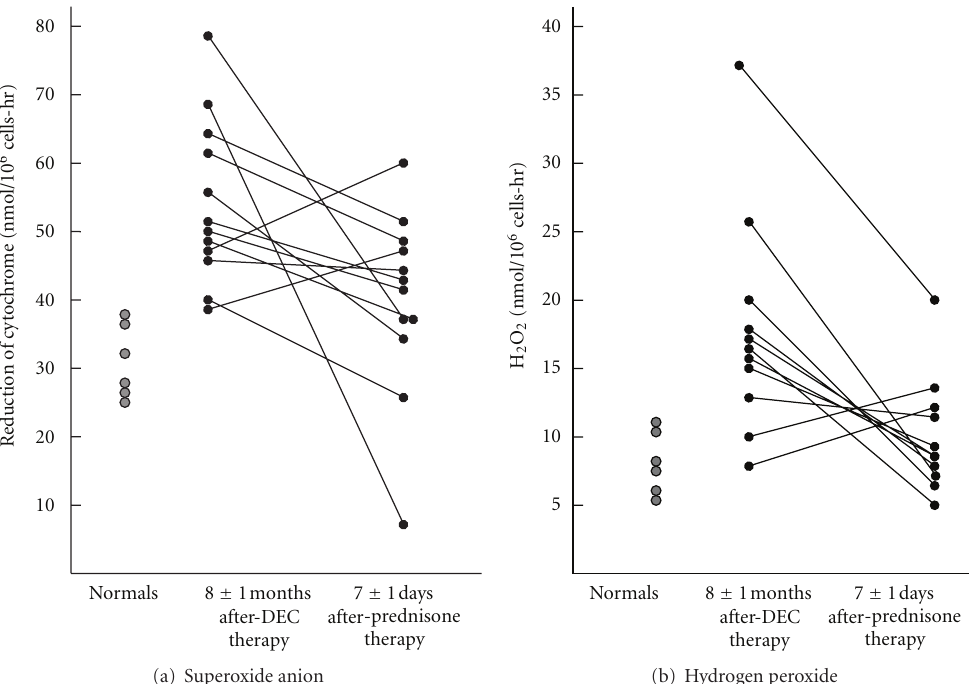
Figure 2: Reduction in the spontaneous release of oxidants by lavage cells after prednisone therapy in TPE patients following diethylcarba- mazine therapy. (a) Superoxide anion. (b) Hydrogen